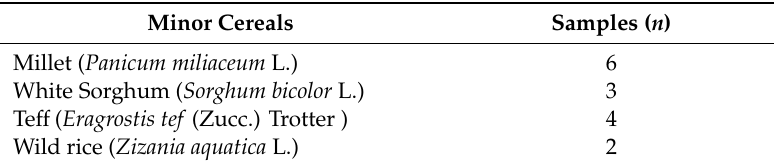
Table 1. List of analysed gluten-free